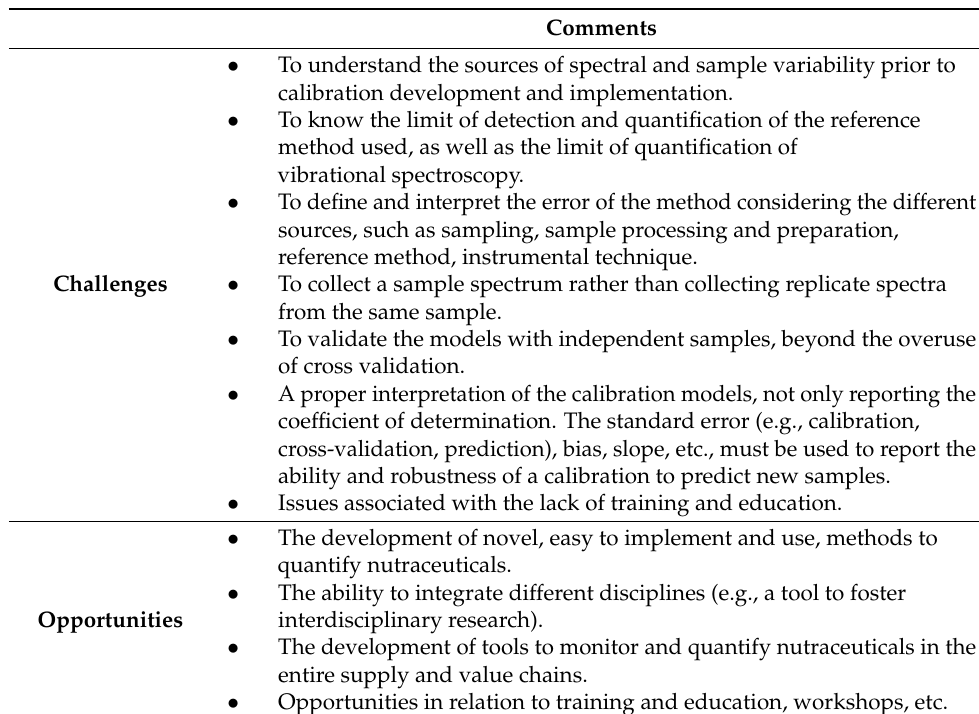
Table 1. Summary of the challenges and opportunities facing the development of applications based on vibrational